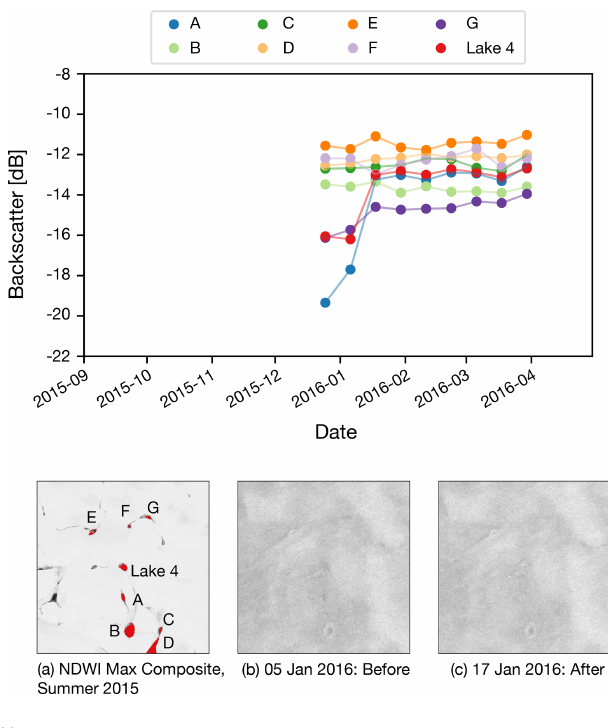
Figure D4. Lake 4 surrounding lakes.